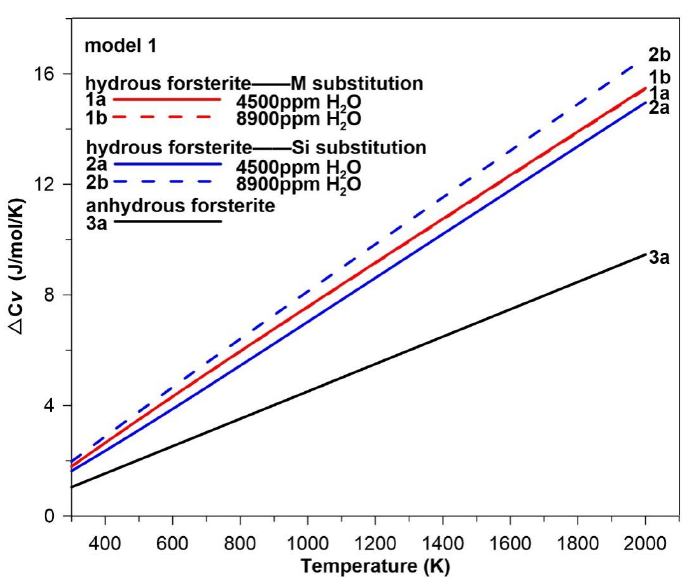
Figure 12. Comparison of the difference of isobaric heat capacities between the cases for harmonic approximation and with intrinsic anharmonic contribution for anhydrous and hydrous forsterite.